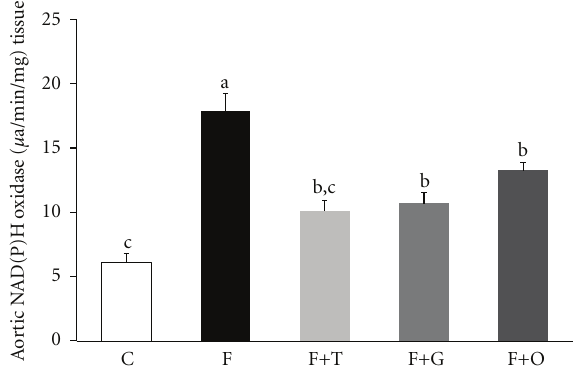
Figure 2: Aortic NAD(P)H oxidase activity C, F, F+T, F+G, and F+O groups ( n = 6 rats per groups). Values are expressed as mean ± SEM, ( n = 6); bars with di ff erent superscripts di ff er, P < 0.05. experimental groups ate less food than C group ( P < 0.05).